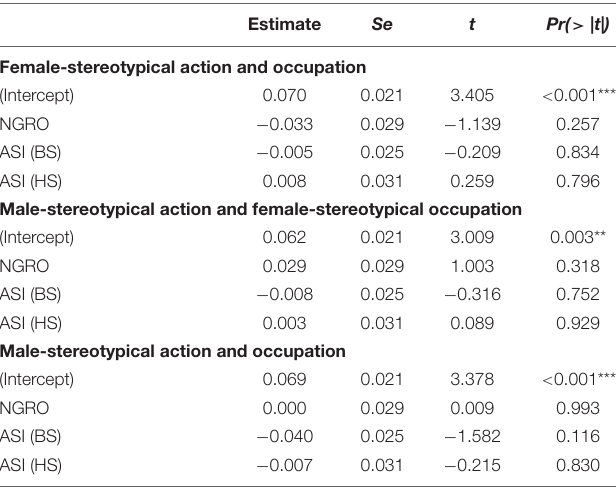
TABLE 1 | Ordinary least square regression results. Within the table (in bold font), the experimental condition of the cluster that served as intercept in each model.